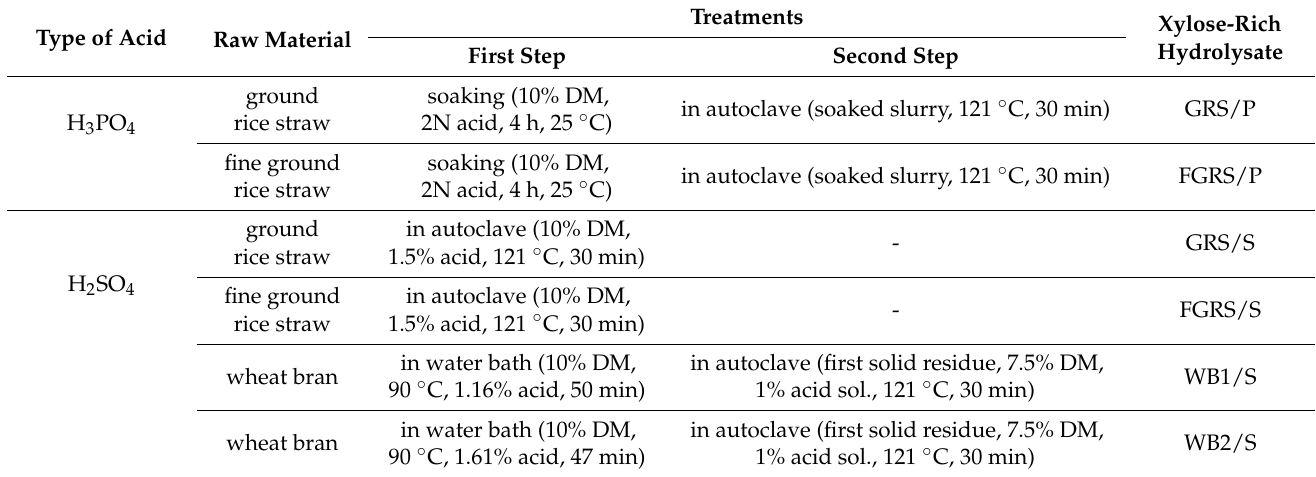
Table 1. Different pre-treatment methods of rice straw and wheat bran for xylose-rich hydrolysates. Treatments Type of Acid Raw Material